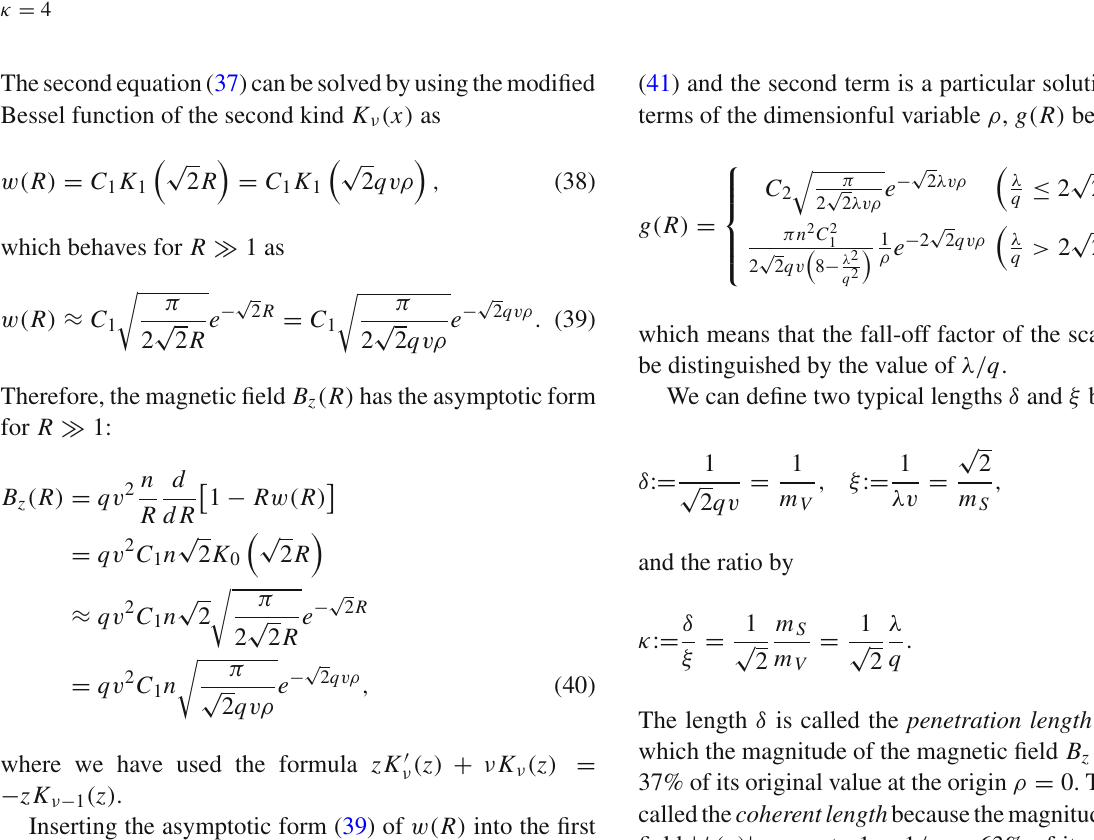
. (Right panel) the type II superconductor with 5